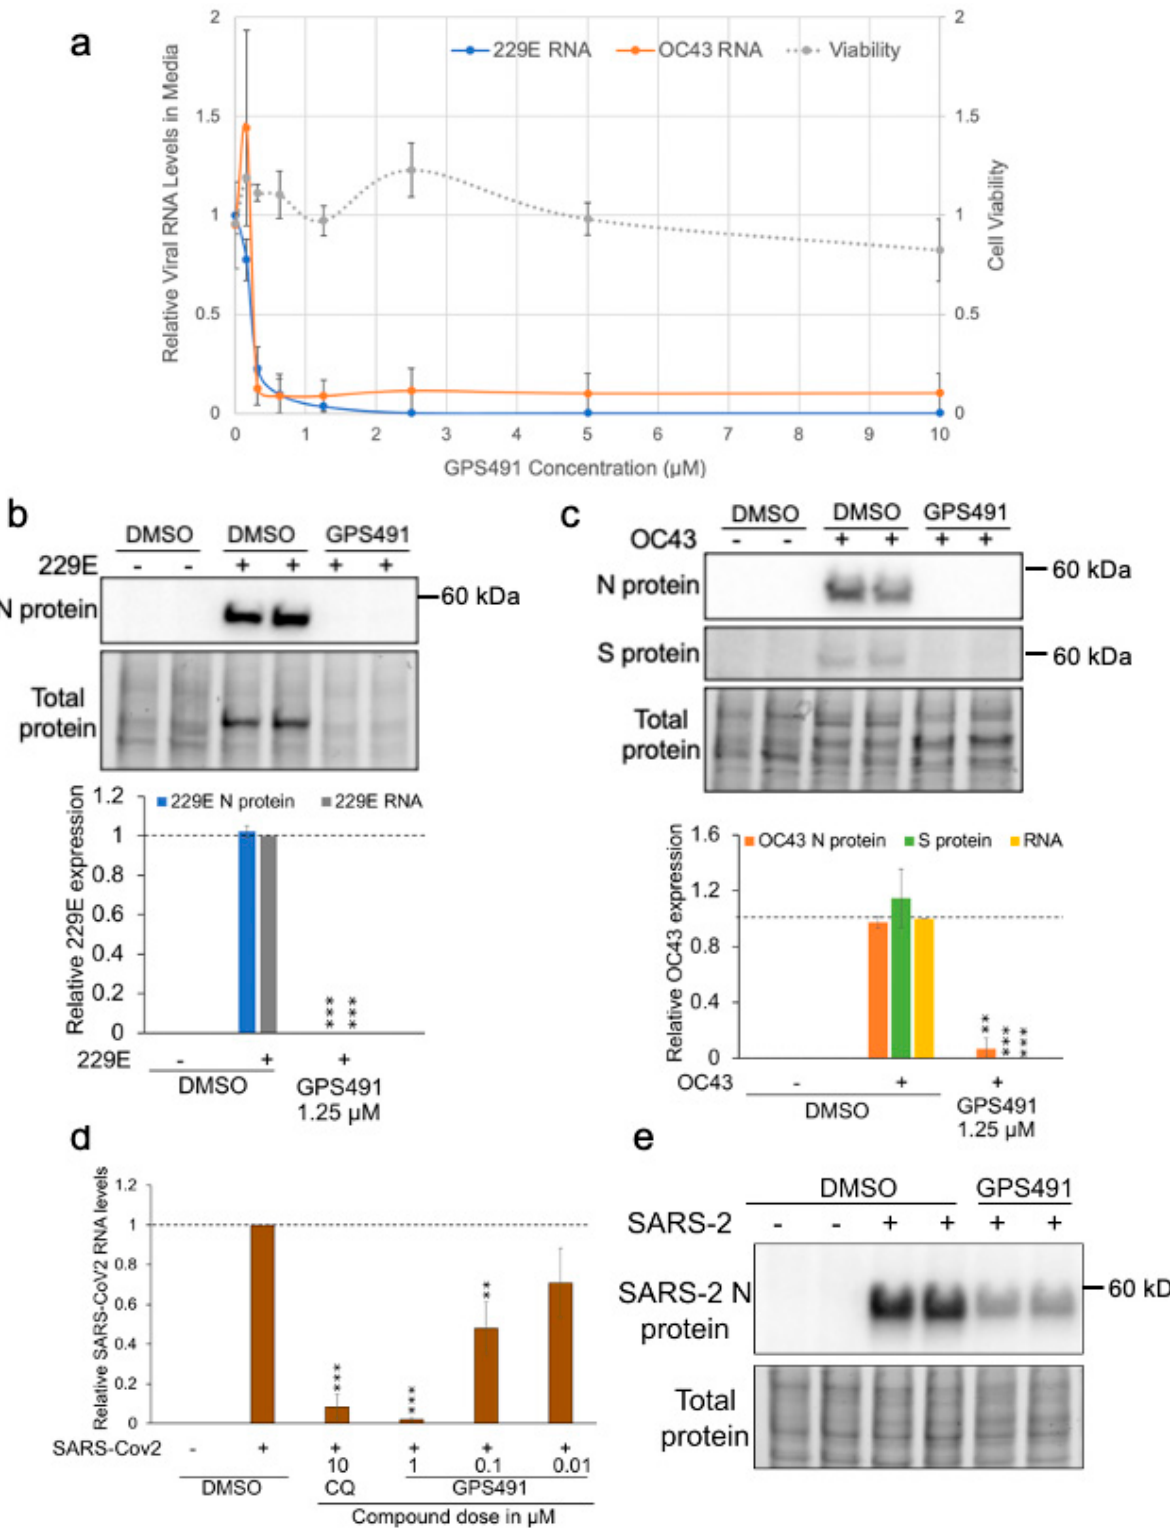
Figure 8. GPS491 inhibits replication of 229E, OC43, and SARS-CoV2 coronaviruses. ( a ) Huh7 cells were infected with either 229E or OC43 at an input MOI of 0.1 and 1, respectively, for 1 h. Virus inoculum was removed, cells were washed, and fresh media containing 1% DMSO or varying concentrations of GPS491 (from 0 µM to 10 µM) were added. Then, 2 days p.i (229E) or 4 days p.i. (OC43), media were harvested to quantitate viral genomic RNA levels by RT-qPCR assay. All the values are expressed relative to the values detected in virus-infected DMSO-treated samples. Effect of GPS491 on cell viability was assessed 2 days post compound addition using alamarBlue at the indicated doses of GPS491. Data are indicated as mean ± SD, ** p ≤ 0.01, and *** p ≤ 0.001. ( b , c ) Huh7 cells were infected with ( b ) 229E at an MOI of 0.03 or ( c ) OC43 at an MOI of 0.3 for 1 h after which the virus inoculum was removed, cells were washed with 1× PBS, and media containing 1% DMSO or 1.25 µM GPS491 were added. Cells and media were harvested 2 days (229E) or 4 days (OC43) p.i., and the levels of viral proteins (N, S) were determined by Western blot and virus production was assessed by RT-qPCR of the media (RNA). Shown are representative Western blots and their respective quantitation indicating the effects of GPS491 following infection with 229E and OC43, respectively. Band intensity was quantified relative to virus-infected control and normalized to total protein load (stain-free gels). Data are indicated as mean ± SD and generated from n = 3 independent assays, each performed in duplicate. ( d , e ) Huh7 cells were infected with SARS-CoV2 at an MOI of 1 for 1 h. Virus inoculum was removed, and